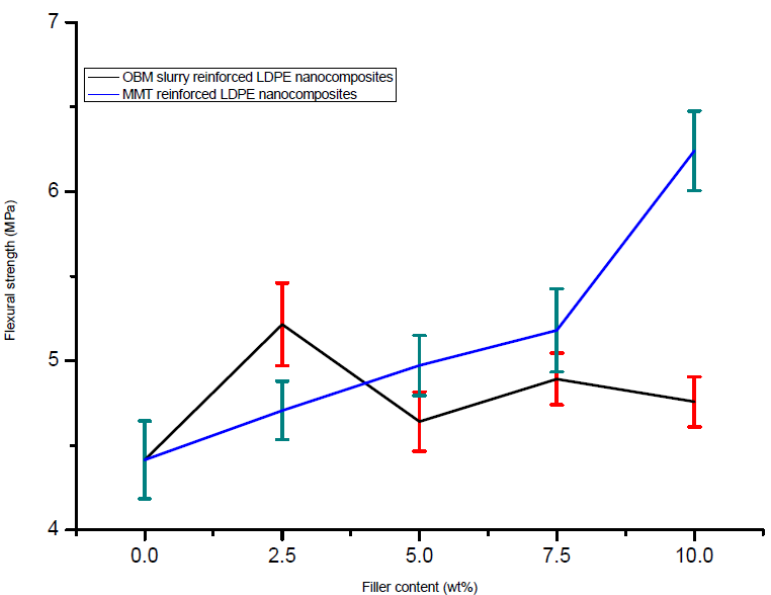
Figure 13. Comparison of flexural strength of LDPE/MMT and LDPE/OBM slurry nanocomposites.